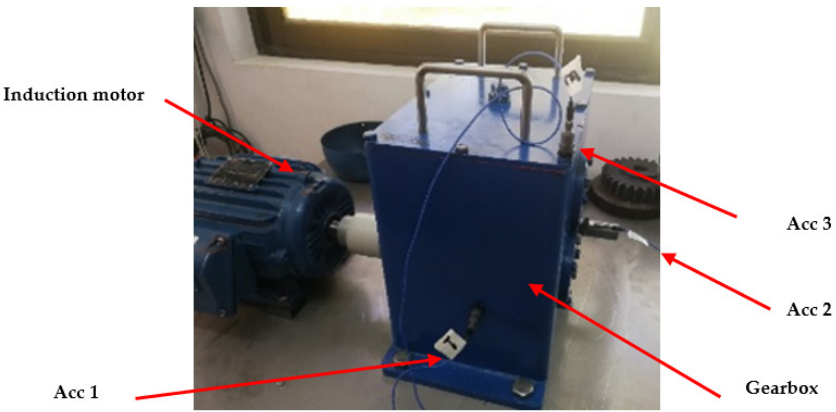
Figure 5. OMA’s measurement set up for the gearbox with mounted accelerometers.